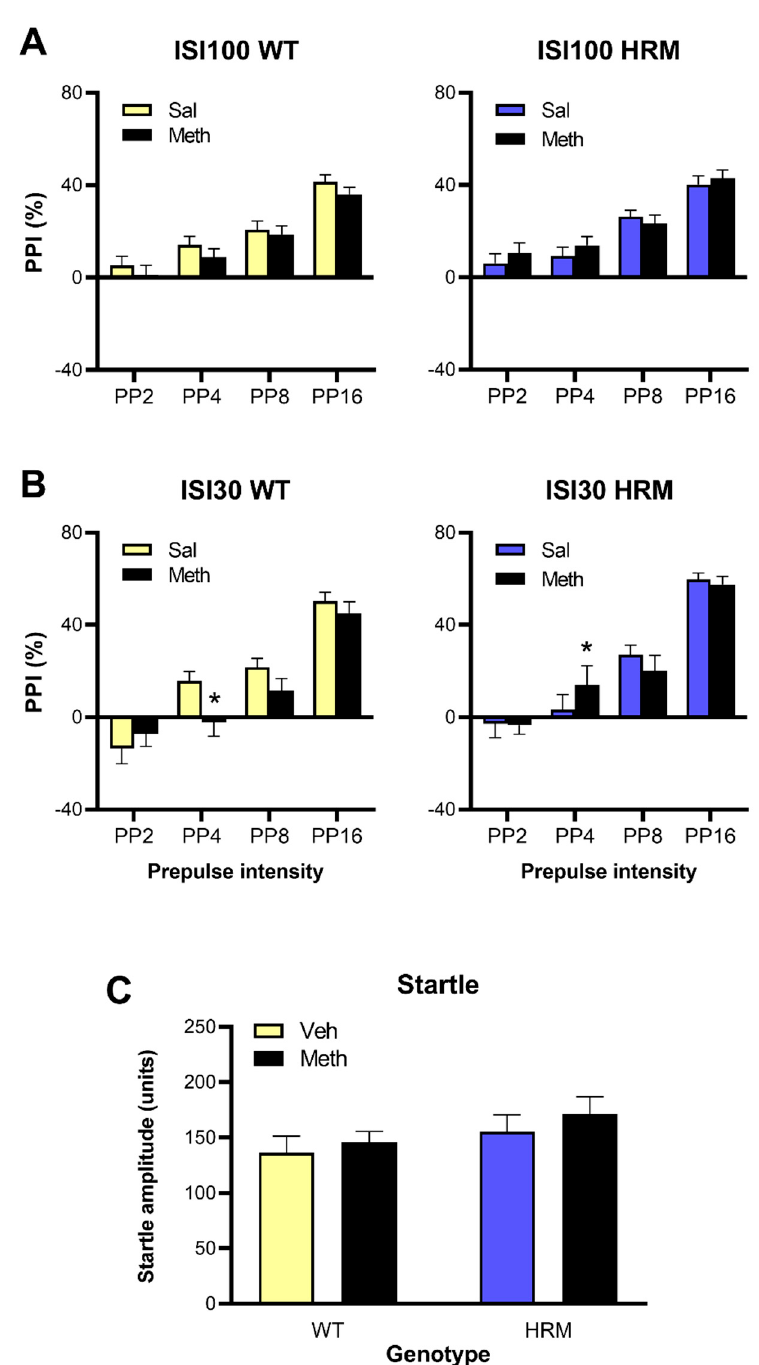
Figure 3. Prepulse Inhibition (PPI) of acoustic startle in WT and HRM pretreated with saline or Meth. Data are expressed as %PPI at prepulse (PP) levels of 2, 4, 8 and 16 dB over baseline (PP2, PP4, PP8, PP16, respectively) and 100 (panel A ) or 30 ms (panel B ) inter-stimulus intervals (ISI100 and ISI30, respectively). There were no differences between Meth and saline-pretreated mice except a decrease of PPI at PP4 and ISI30 in WT as opposed to an increase in HRM (* p < 0.05). Panel C shows there was no difference in average startle amplitudes between the groups. Data are mean ± SEM of males and females combined.